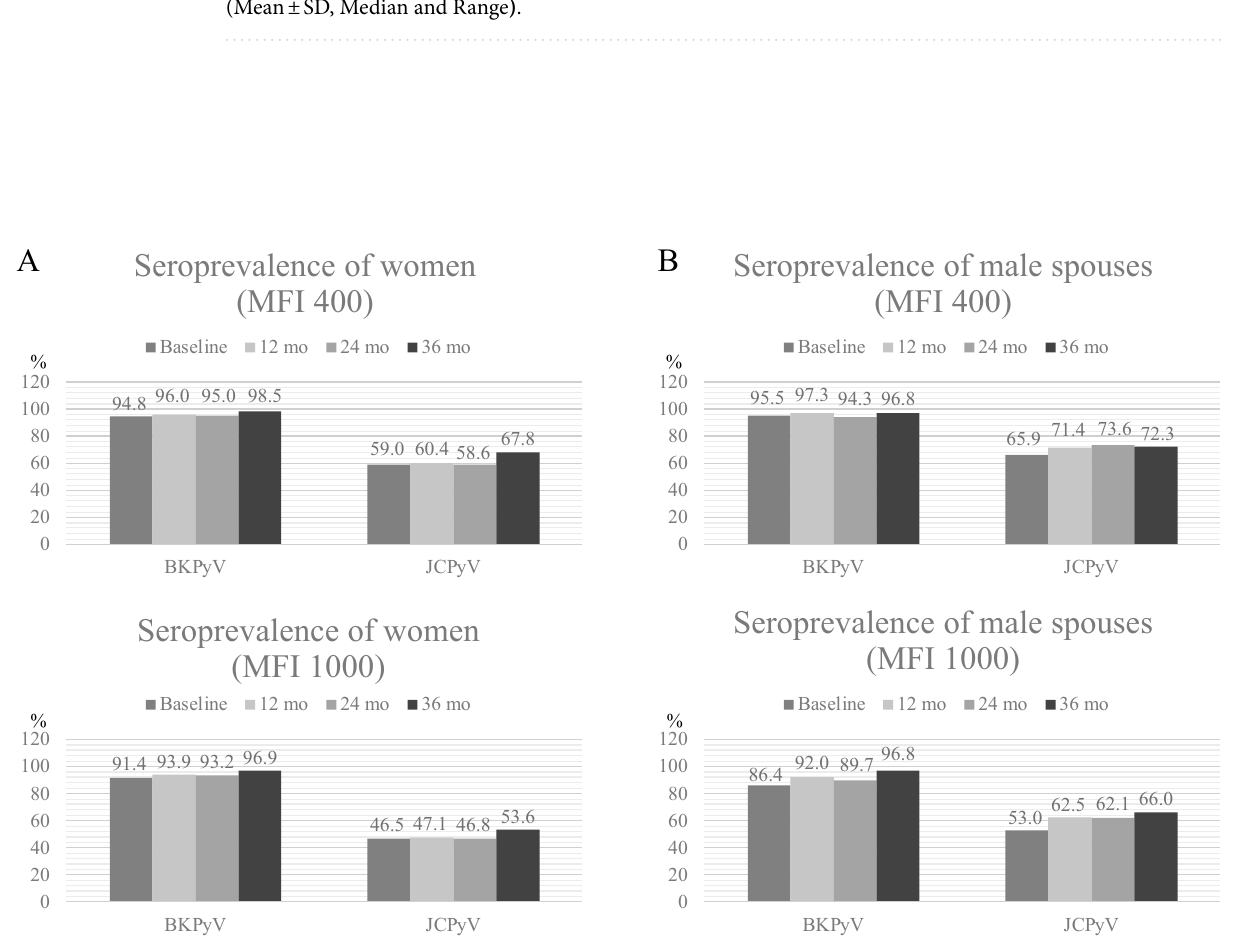
Table 1. Serum IgG-antibody levels of BK (BKPyV) and JC (JCPyV) polyomaviruses in pregnant women at their 3rd trimester and their male spouses from the Finnish Family HPV study at baseline and at the 12-, 24-, and 36- month follow-up visits. Antibody levels were given as median fluorescence intensity (MFI) values (Mean ± SD, Median and Range ) .